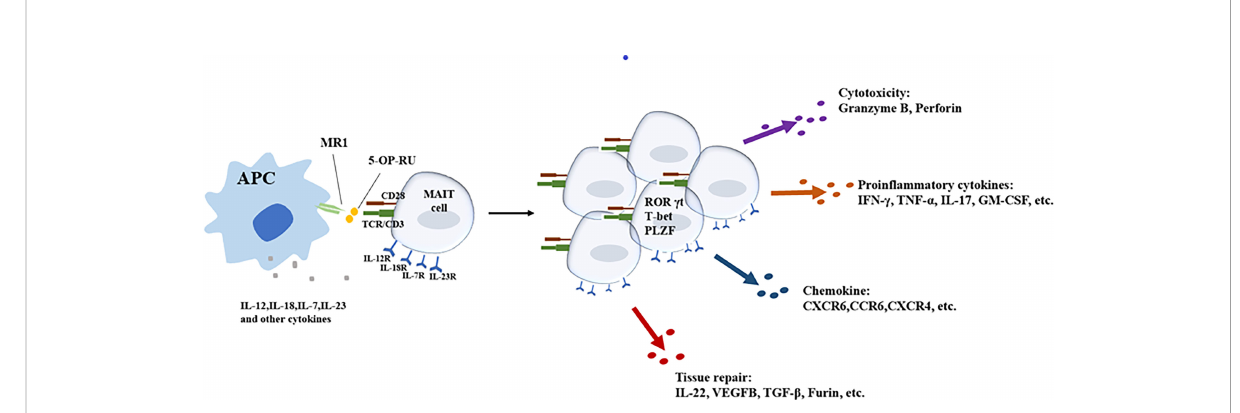
FIGURE 1 Different activation pathways of MAIT cells and main effector functions of activated MAIT